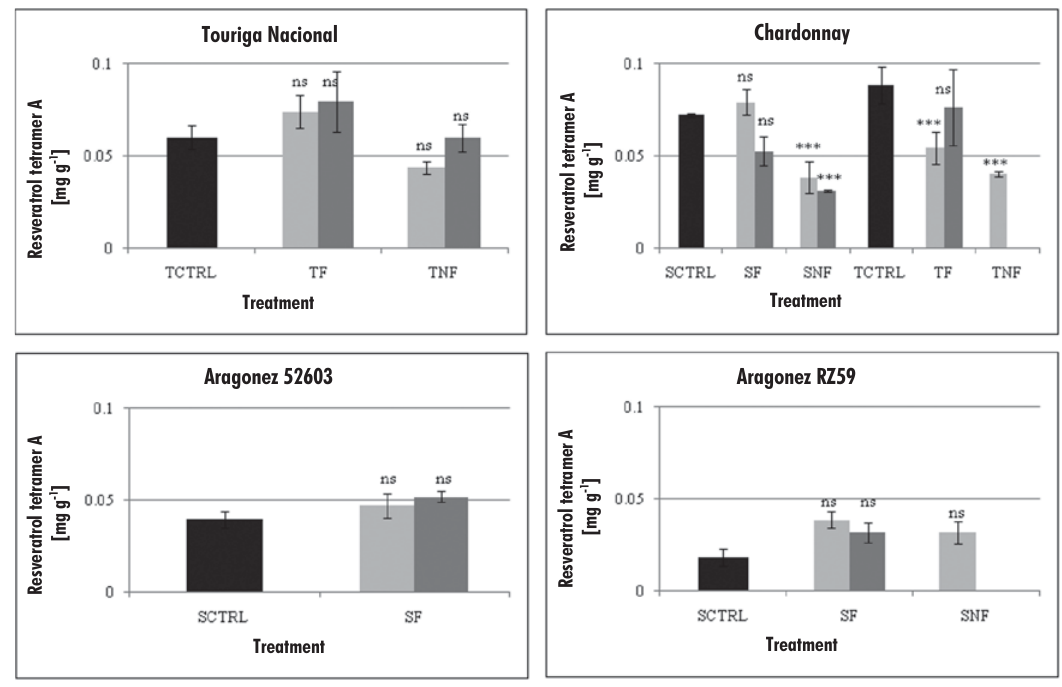
Fig. 5. Resveratrol tetramer A content in healthy and infected plants, from cv. Touriga Nacional, cv. Chardonnay, cv. Aragonez (52603) and cv. Aragonez (RZ59). Different tissue types are represented with infected plants: colonised trunk tissue (TF), uncolonised trunk tissue (TNF), colonised shoot tissue (SF) and uncolonised shoot tissue (SNF). Error bars represent standard deviation (n=4). Level of statistical signi fi cance is also indicated as *, P <0.05; **( P <0.01); ***, P <0.001; ns, non-signi fi cant. Control ( ¢ ), PH9 ( ¢ ), PH13 ( ¢ ). For control treatments, TCTRL refers to trunk control and SCTRL refers to shoot